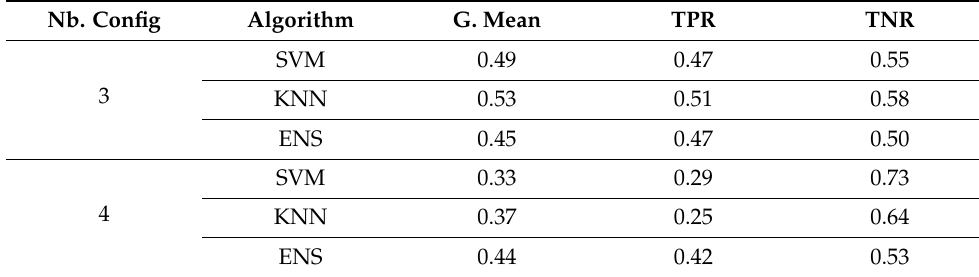
Table 9. Performance metrics for catecholamines